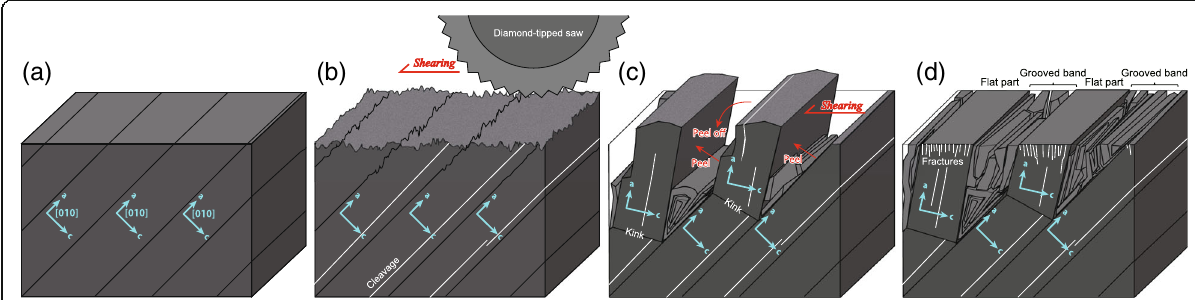
Fig. 7 Schematic diagram showing deformation of the crystal structure of polished graphite. a Original graphite structure prior to sample preparation. b Graphite structure after cutting by a diamond-tipped saw. The surface condition is disturbed, and cleavages developed within the graphite sheets. c Graphite sheets are peeled by shearing during polishing, and a gap is formed between them. The kink is formed by bending of the graphite sheet. The peeled graphite sheet further peels off, and fragments of the sheet fill the gap. d The final crystal structure of graphite is disturbed by polishing. Fractures are concentrated near the polished